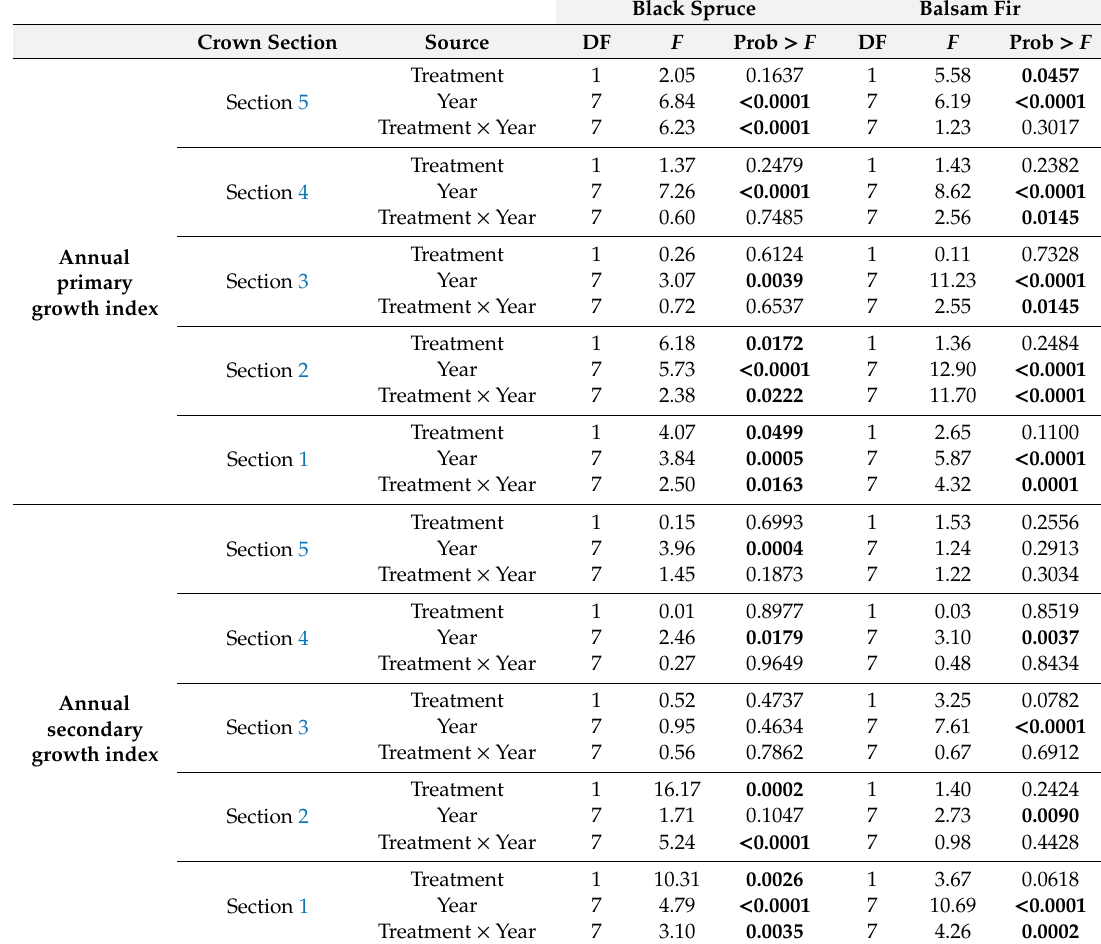
Table 3. Results from mixed model of the branch annual primary and secondary growth along the live crown for black spruce and balsam fir in the years after CLASS. Section 1 represents the base of the crown, and Section 5 represents the top of the tree. Significant results are presented in